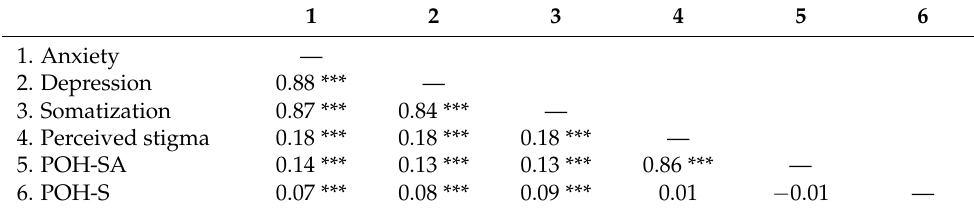
Table 2. Zero-order correlational matrix.